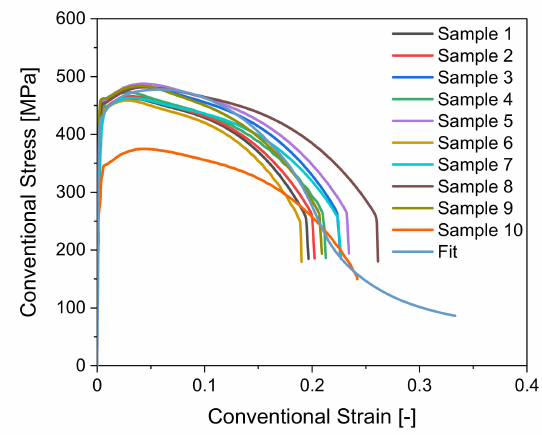
Figure 7. Conventional stress–strain curves with fitted